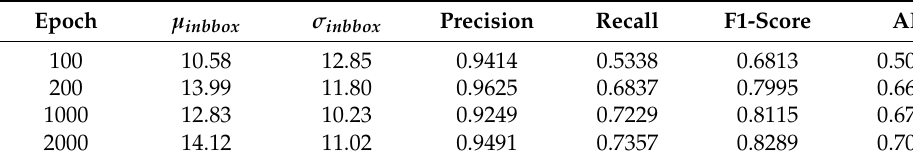
Table 2. µ inbbox , σ inbbox , Precision, Recall, F1-score, and AP of the training YOLOv3.